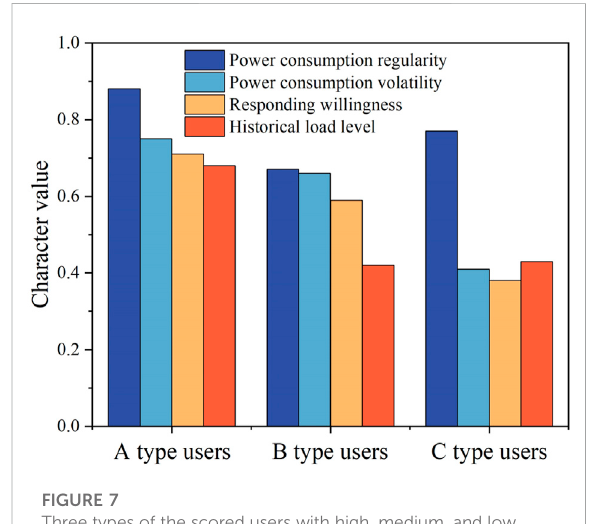
FIGURE 7 Three types of the scored users with high, medium, and low IDR adaptabilities.